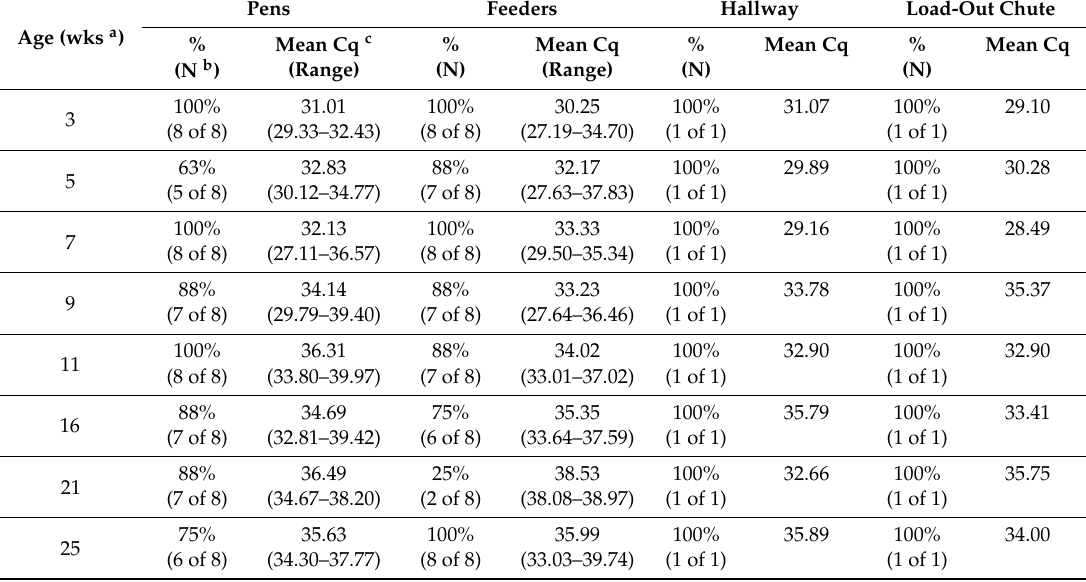
Table 3. PoAstV3 detection frequency and RT-qPCR mean Cq and Cq range by environmental sample type over time.